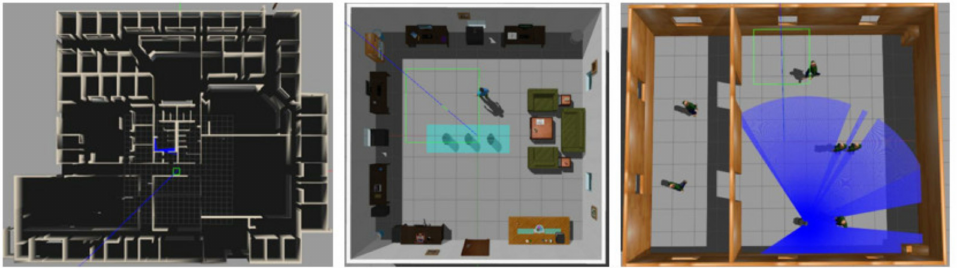
Figure 5. The virtual testing environments used in this